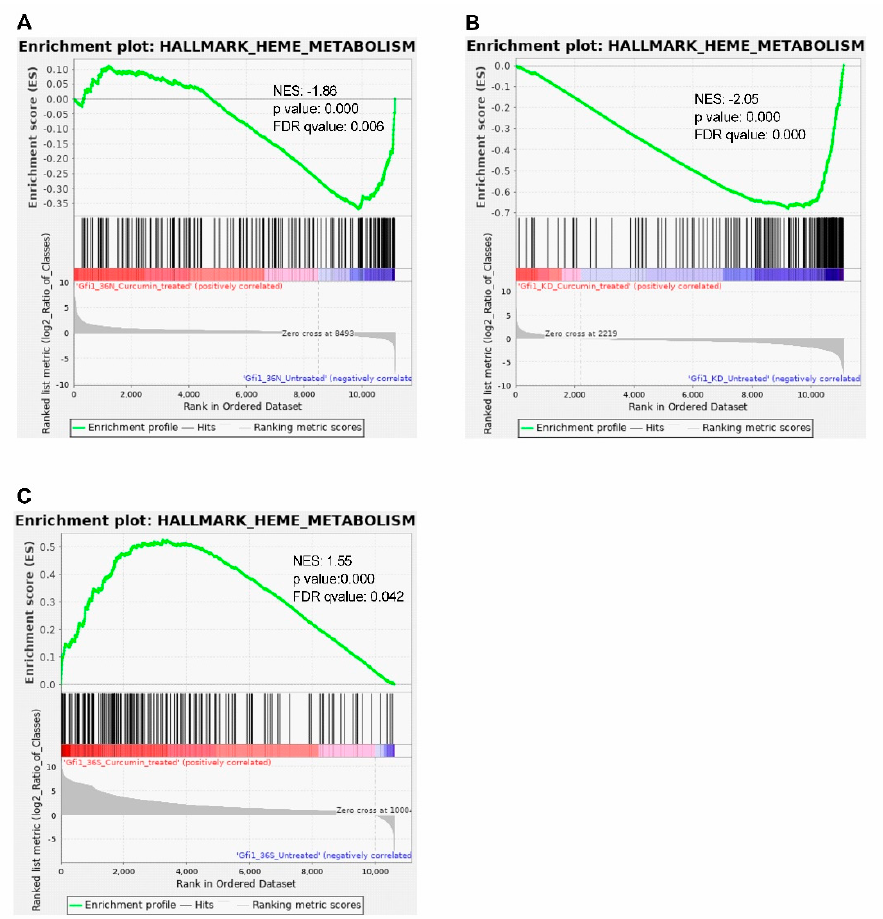
Figure A4. GSEA analysis based on ChIP-seq data identified differential regulation of hallmark heme-metabolism in curcumin-treated GFI1-36N and -KD, NUP98-HOXD13-tg mice. Representative hallmark heme-metabolism enrichment plots in GFI1-36N ( A ) , -KD ( B ) and -36S ( C ) , NUP98-HOXD13-tg mice.